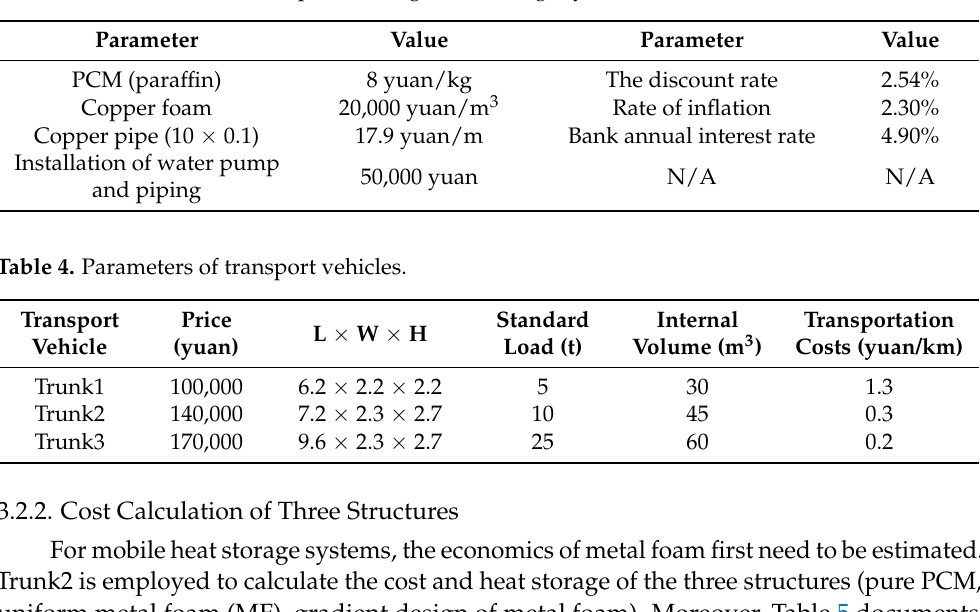
Table 3. Parameters of mobile phase change heat storage system.